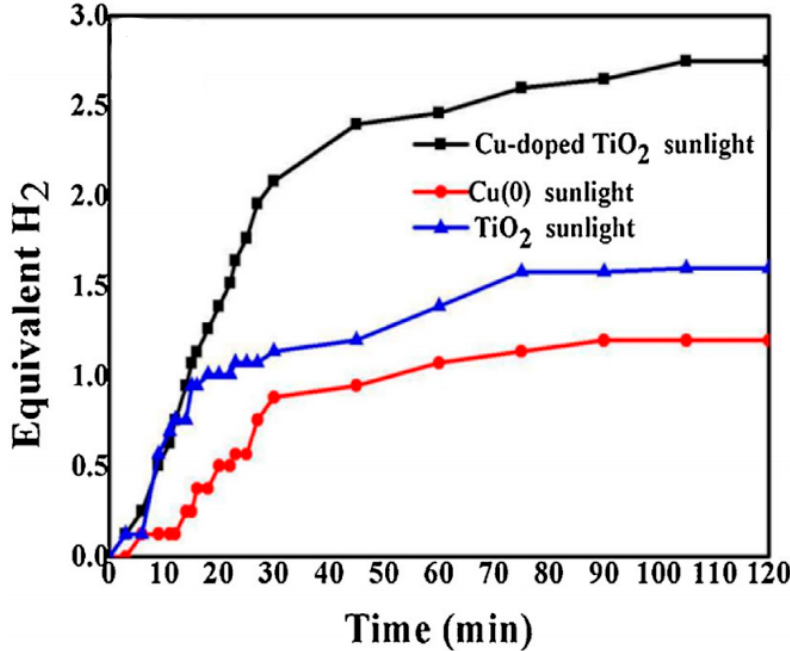
Figure 18. Catalytic performance of TiO 2 NFs with and without the incorporation of Cu(0) in sun- light for AB hydrolysis reaction. Reprinted from reference [14] with permission from